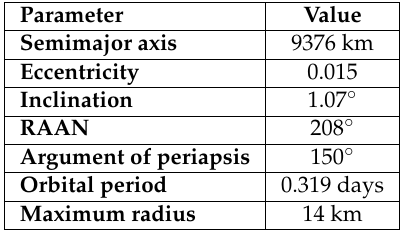
Table 6. Parameters used to model the orbit and spacecraft dynamics around